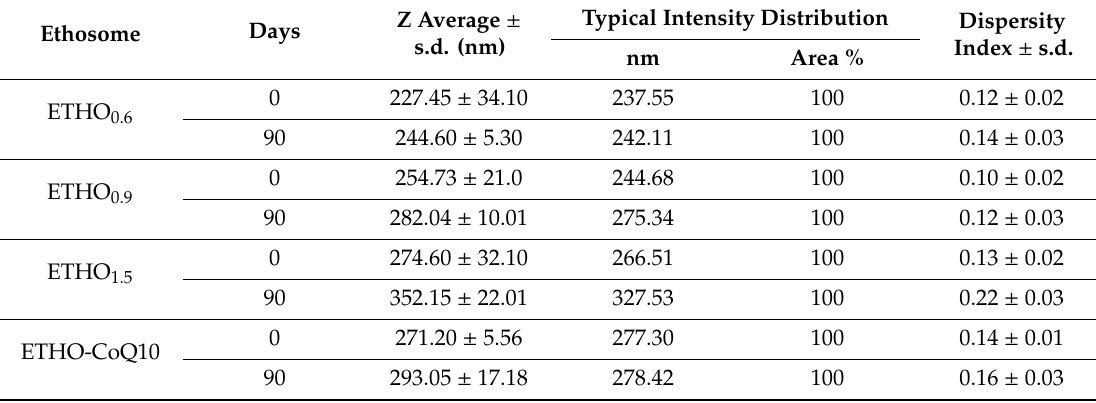
Table 2. Dimensional distribution parameters of ethosomes, as determined by